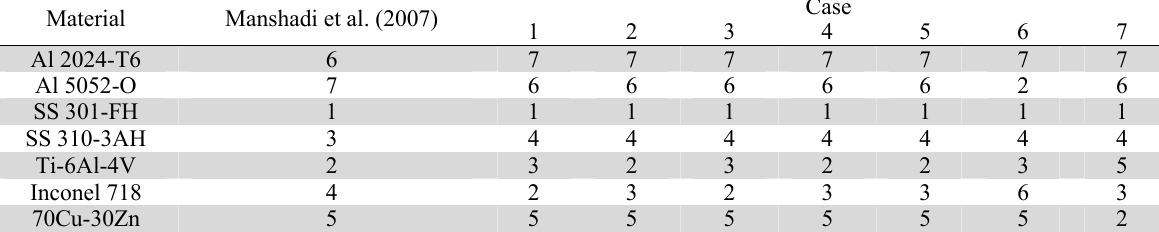
Rankings of cryogenic storage tank materials using PROMETHEE method Material